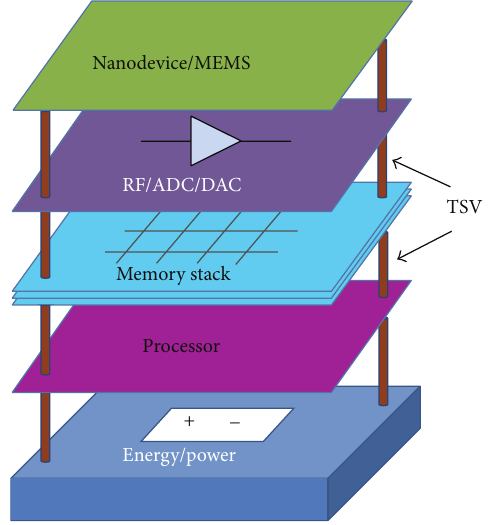
Figure 1: TSV based 3D